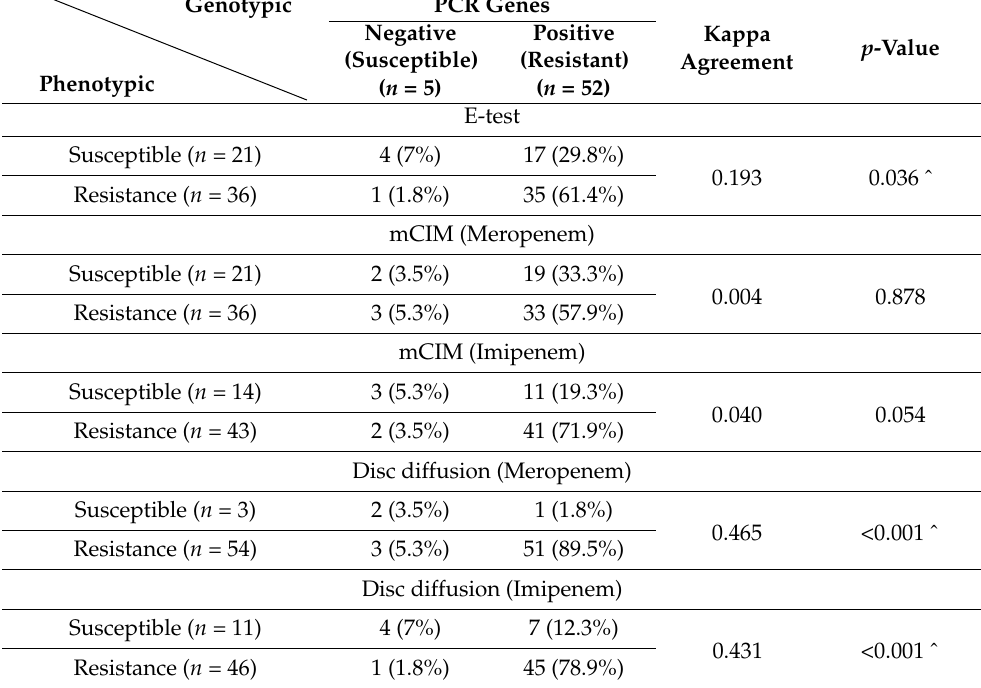
Table 7. Agreement between genotypic and phenotypic